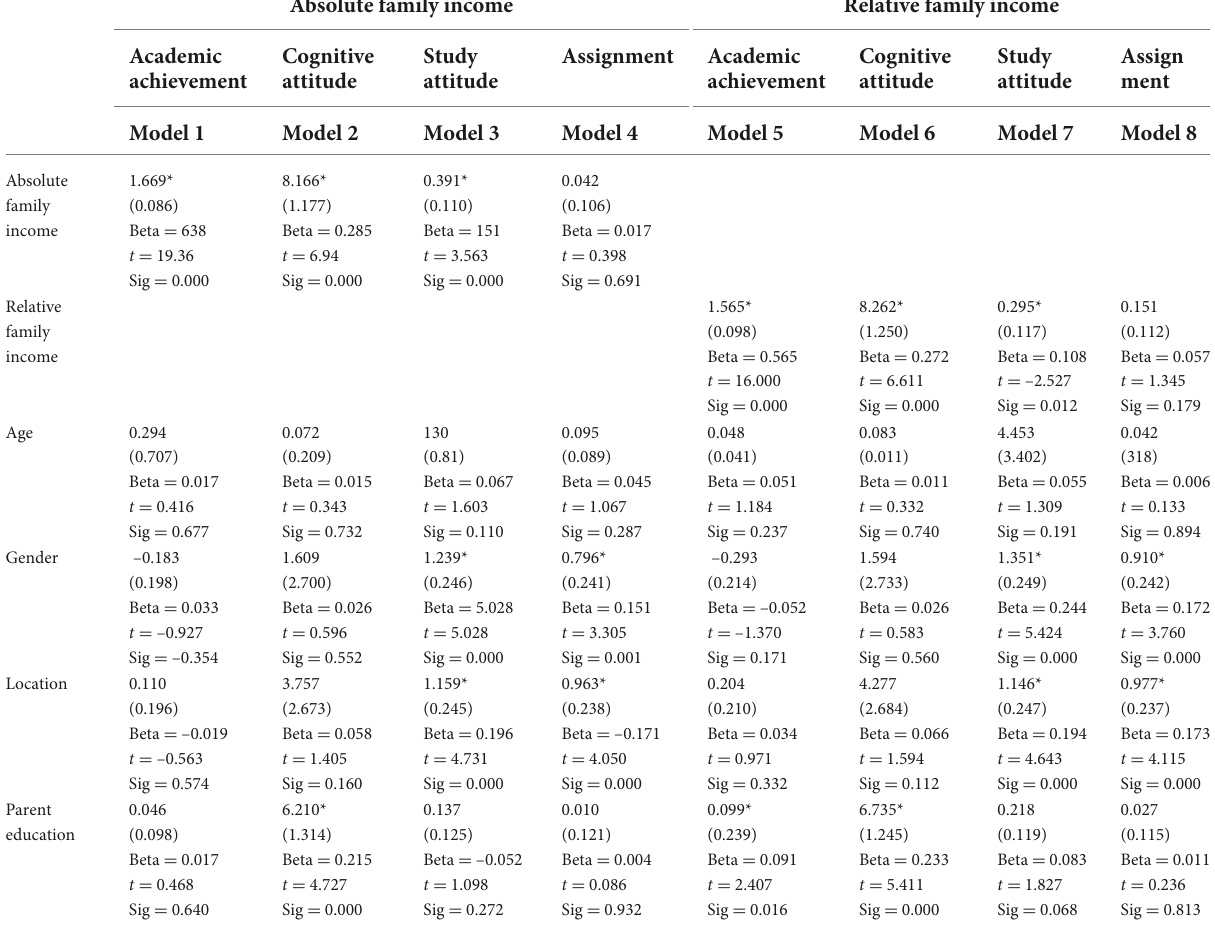
TABLE 2 Regression statistics of the relationship between family income, academic achievement, cognitive ability, and